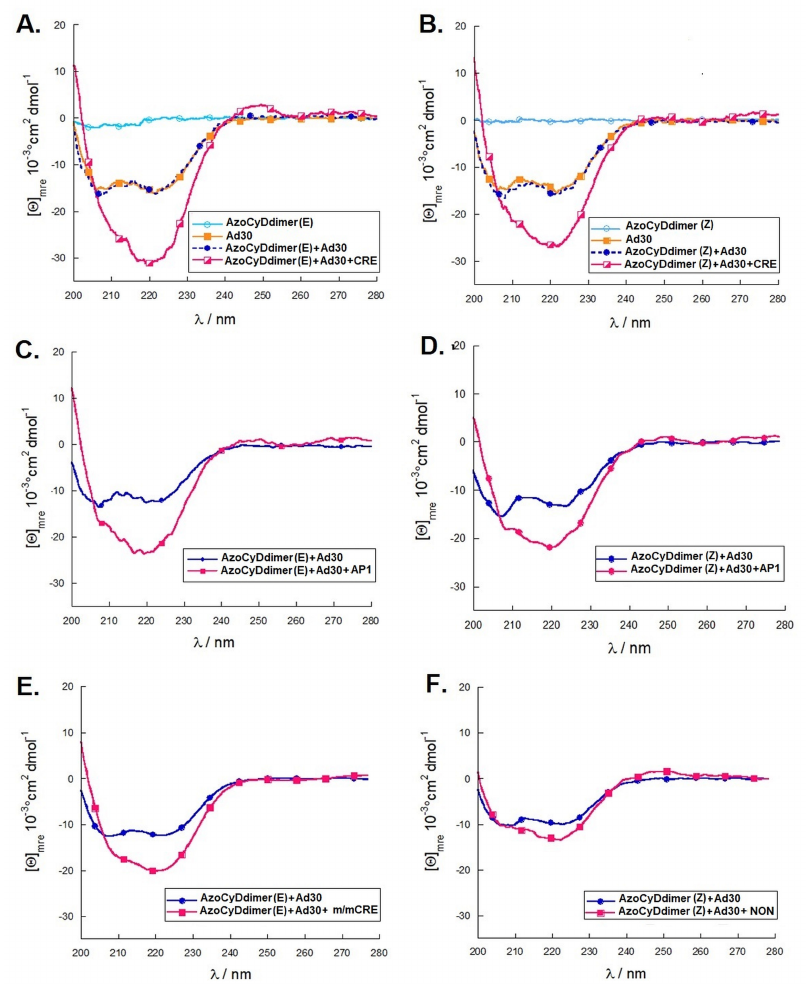
Figure 6. Circular dichroism evaluation of the interaction of Ad30 ( A ) with azoCyDdimer (E) and its cognate sequence CRE ( (cid:48) 5-cggATGA cg TCATtttttttc-3 (cid:48) ), ( B ) with azoCyDdimer (Z) and its cognate sequence CRE ( (cid:48) 5-cggATGA cg TCATtttttttc-3 (cid:48) ), ( C ) with azoCyDdimer (E) and its cognate sequence AP1 ( (cid:48) 5-cggATGA c TCATtttttttc-3 (cid:48) ), ( D ) with azoCyDdimer (Z) and its cognate sequence AP1 ( (cid:48) 5-cggATGA c TCATtttttttc-3 (cid:48) ), ( E ) with azoCyDdimer (E) and mCRE ( (cid:48) 5-cggATGAcgttgtttttttc-3 (cid:48) ), and ( F ) with azoCyDdimer (E) in the presence of a random sequence, NON ( (cid:48) 5-ggtatgcgtcgatttttttc-3 (cid:48) ). In all experiments, the band of dsDNA was subtracted; for further experimental details refer to Materials and Methods